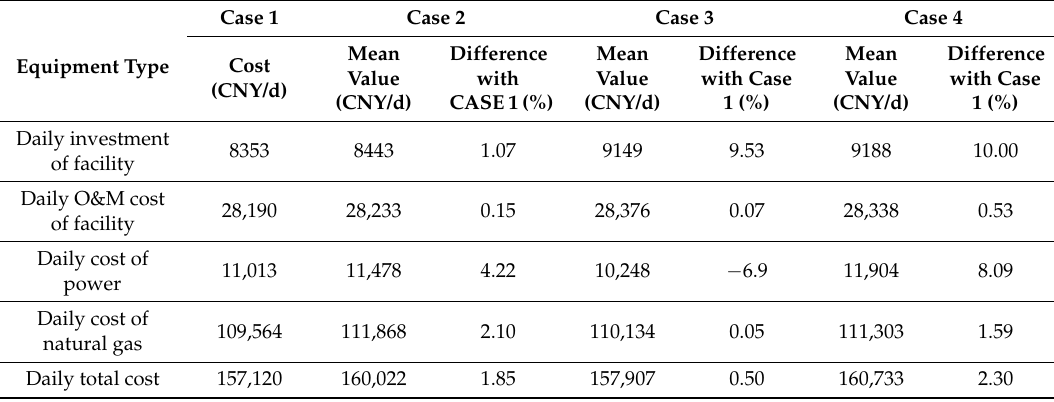
Table 6. Daily cost of the system in different cases.